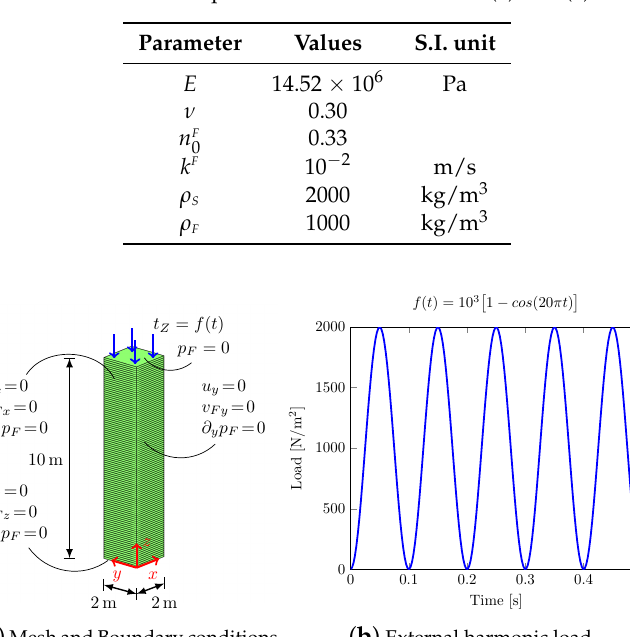
Table 1. Material parameters for benchmarks (1) and (2).